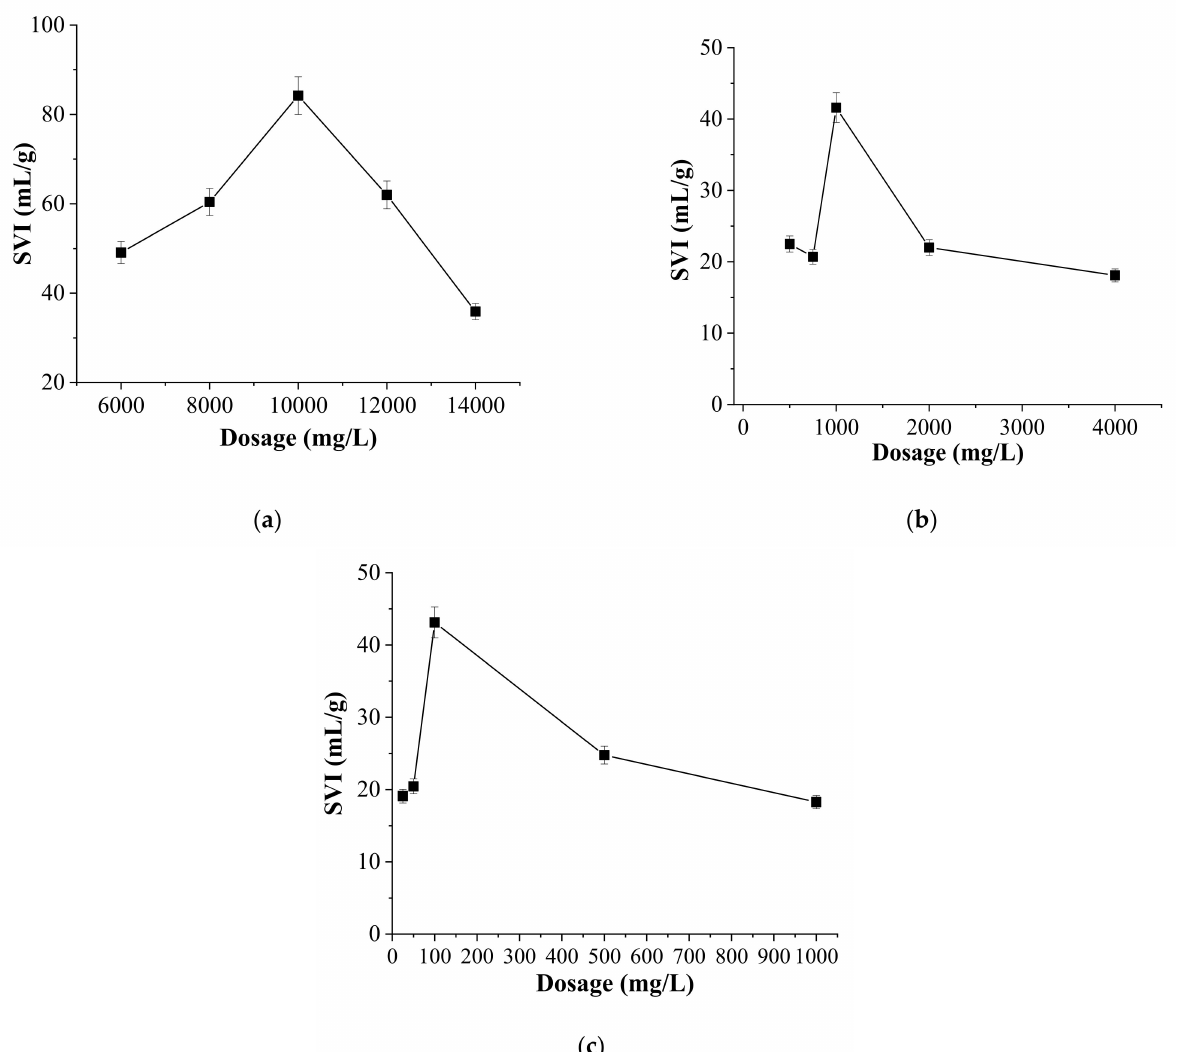
Figure 8. Sludge velocity index (SVI) at pH 8 for ( a ) 10,000 mg/L SnCl 4 ; ( b ) 8000 SnCl 4 mg/L + 1000 mg/L RS; ( c ) 8000 mg/L SnCl 4 + 100 mg/L